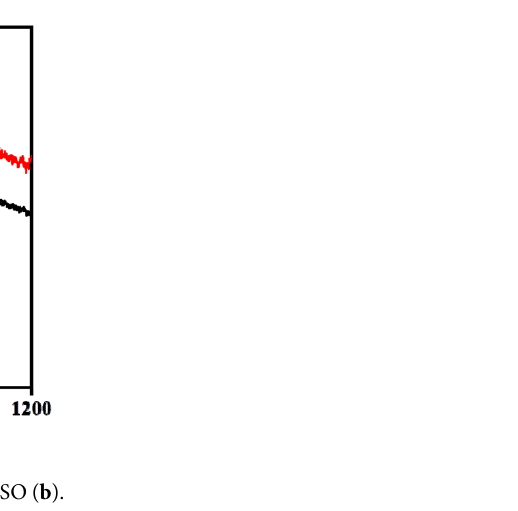
phase 52,53 . Elemental mapping of the samples indicate a homogeneous distribution of the two elements in the samples (Figure S7, ESI). The surface composition and chemical states of NiS were examined by XPS. The analysis was carried out for the NiS sample synthesized from complex (2) at 250 °C (NISO), and one representative sample from the short chain xanthate (NISE-1). The survey spectra of both NISE-1 and NISO depict the presence of Ni, S, O and C (Fig. 4). The observed oxygen signal can be ascribed to partial oxidation resulting from NiS exposure to air. The presence of carbon is most likely attributed to the surface ligands generated during decomposition of the precursors 45,63 . The Ni 2p, S 2p, and C 1 s spectral regions of the two NiS samples were fitted by the Gaussian method, and are shown in Fig. 5. The Ni 2p region of NISE-1 displays four peaks. The peaks located at 853.4 and 871.4 eV can be assigned to the Ni 2p 3/2 and Ni 2p 1/2 states of Ni 2 + respectively, whereas those observed at 859.2 and 878 eV are the corresponding satellite peaks (Fig. 5a) 64,65 . For the S 2p spectrum, the peak at 160.8 eV cor- responds to S 2p 3/2 , and suggests that the sulfur species in NISE-1 exist as divalent ions (S 2 − ). The broad peak at 165.9 eV is associated with the oxidized species of sulfur (SO x2 − ) (Fig. 5b) 65–67 . This observation lines up with the oxygen signal displayed at 529.9 eV. The two peaks displayed in the C 1 s spectrum can be attributed to the C-C (283.1 eV) and C-O (286.7 eV) bonds originating from the precursor decomposition products (Fig. 5c). Similar